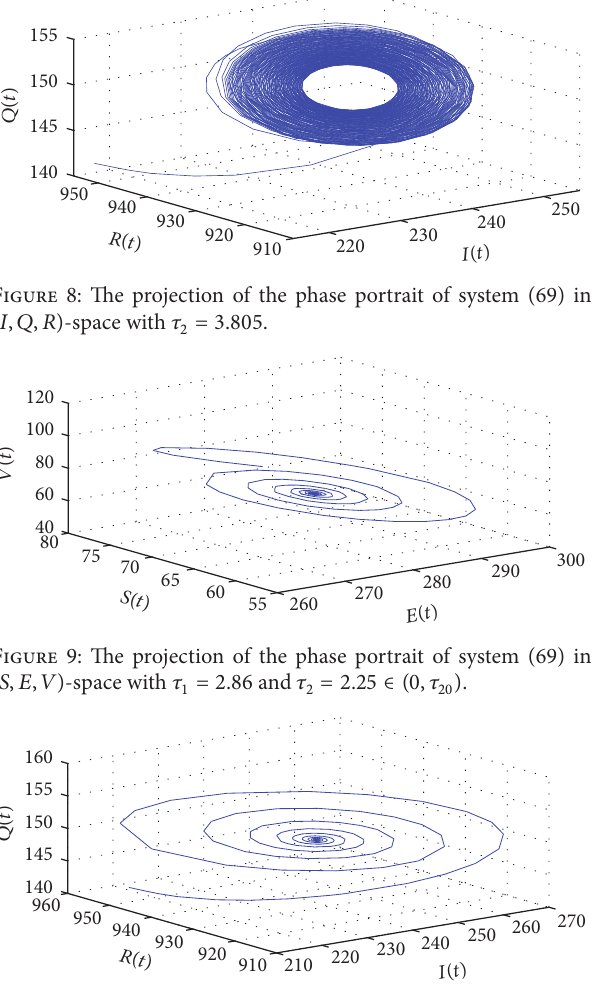
Figure 10: The projection of the phase portrait of system (69) in (𝐼, 𝑄, 𝑅) -space with 𝜏